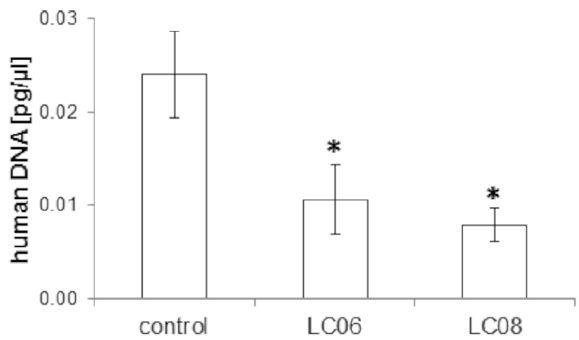
Figure 4. Tumor cell dissemination to the lungs in orthotopic KPL-4 xenograft tumors after LC06 and LC08 treatment. Treatment with LC06 and LC08 resulted in a significant reduction of disseminated tumor cells to the lungs (n=10, *p , 0.05 compared to control, Student’s t-test). The results were confirmed in two in- dependent experiments. Results are expressed as mean 6